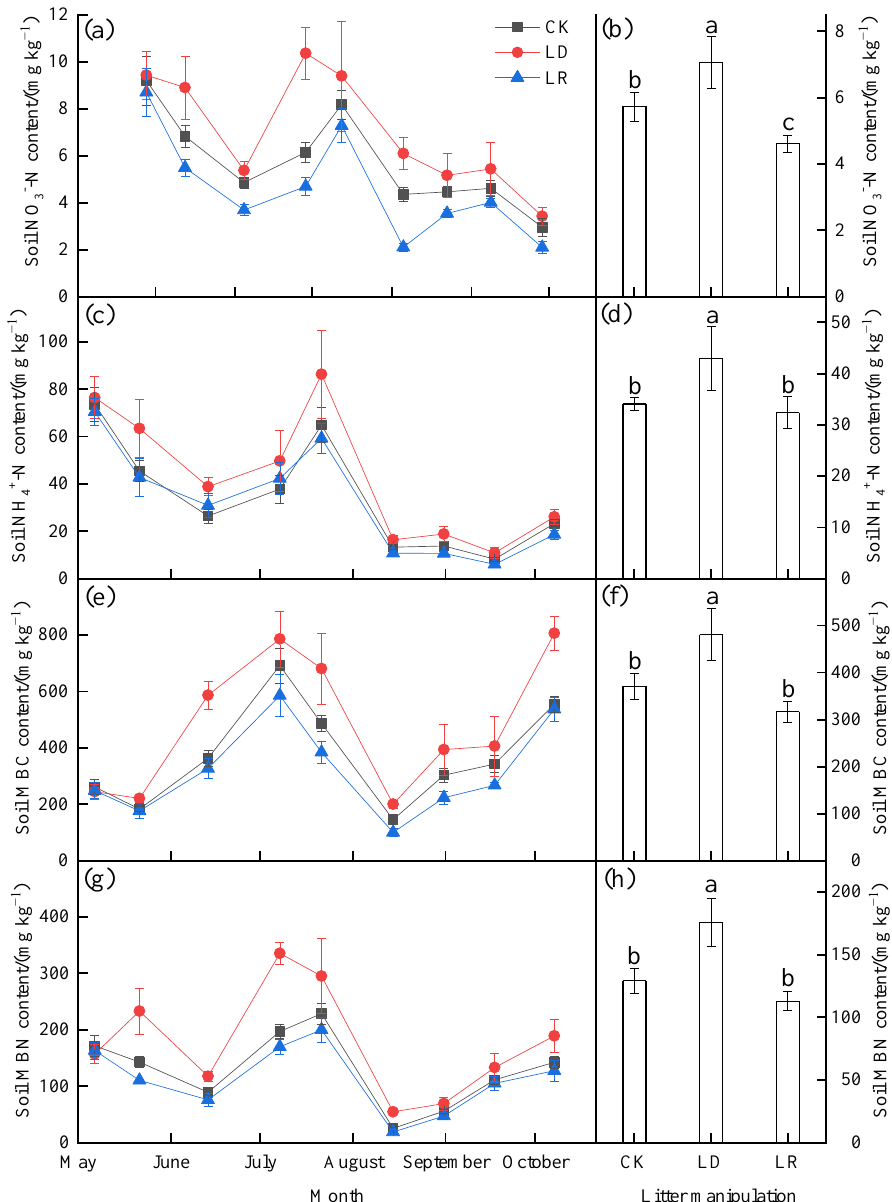
Figure 3. Monthly variations in the soil NO 3 − − N ( a ), NH 4+ − N ( c ), MBC ( e ), and MBN ( g ) contents, and their averages ( b , d , f , h ) under different litter manipulation treatments during the study period ( n = 3). The subplots with three bars show the average soil temperature and water content for the entire study period. The different lowercase letters above the bars indicated significant differences among different litter manipulation treatments ( n = 27); values are the mean ± SD. Litter manipulation treatment abbreviations: CK, unchanged litter input; LD, doubled litter; LR, litter